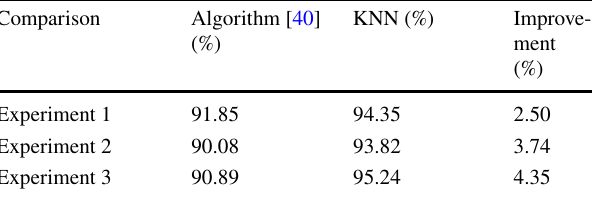
Fig. 4 Average accuracy rate (Single and double degree of membership)